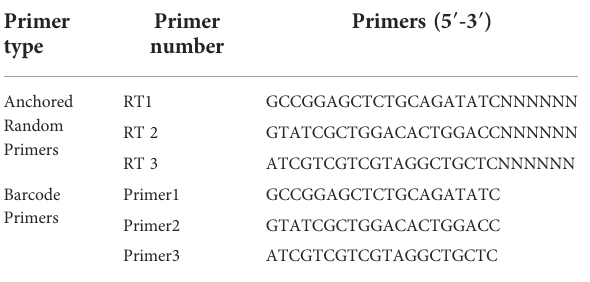
TABLE 1 Barcode DNA employed in metagenomic analysis (Pengpeng et al.,